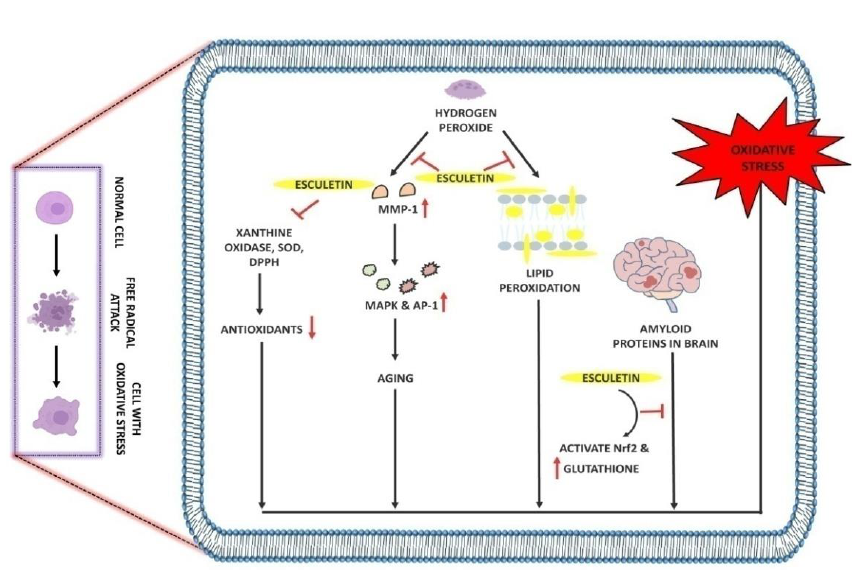
Figure 3. Antioxidant effect of esculetin: Esculetin blocks the activity of H 2 O 2 which further inhibits